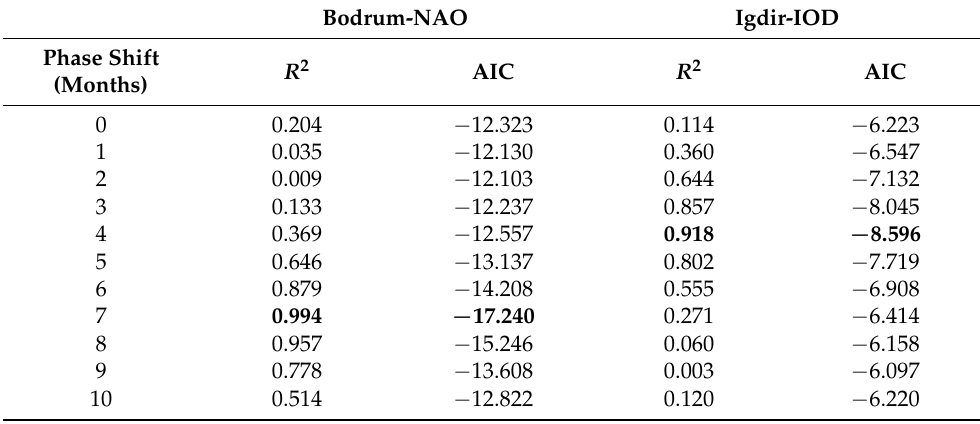
Table 3. The R 2 and Akaike information criterion (AIC) values for Bodrum-NAO and Igdir-IOD (Bold values indicate highest